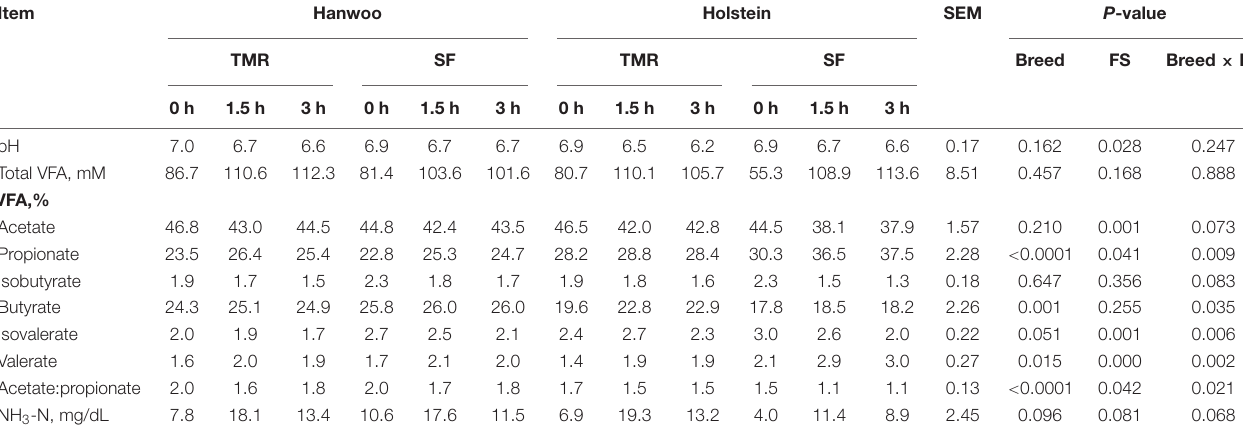
TABLE 5 | Effects of feeding system and host breed on ruminal fermentation characteristics a . Item Hanwoo